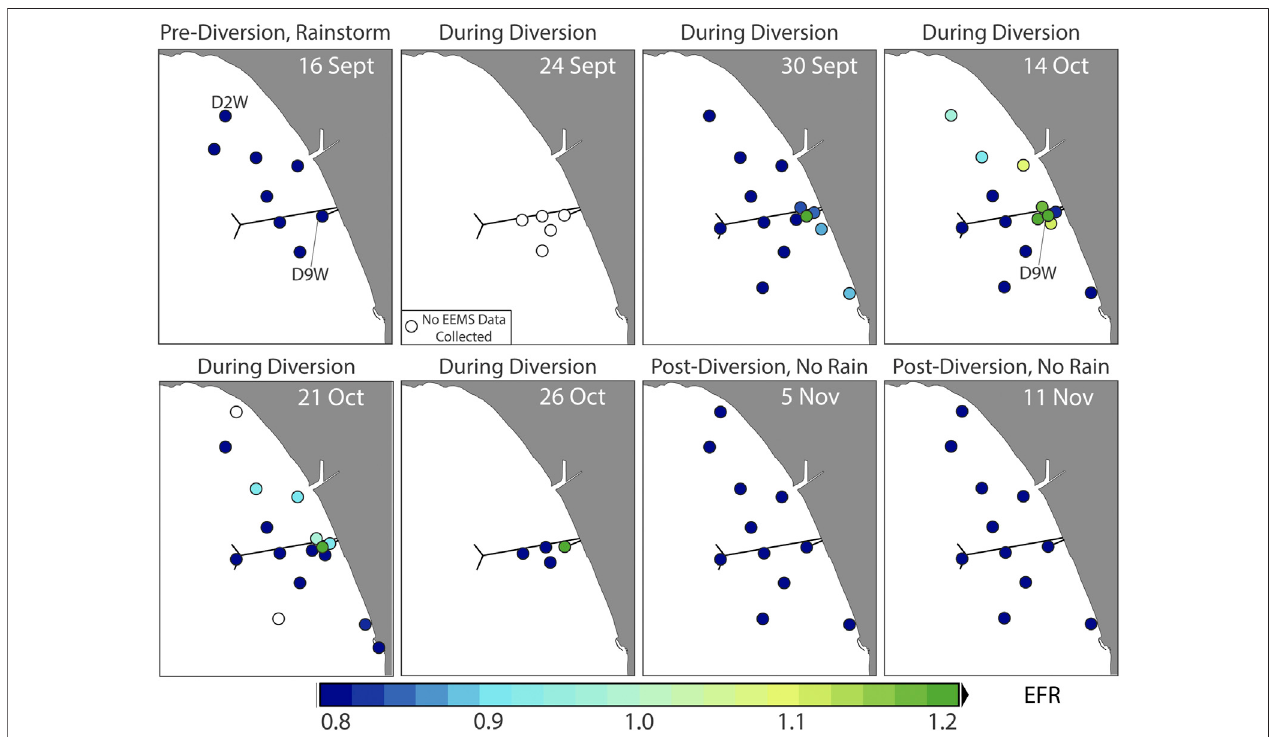
FIGURE7| Distributionof in-situEFR inSantaMonicaBayduringthesamplingwindow.NoEEManalysiswasconductedforSeptember24. EFR values > 1.0were only detected near the outfall during the diversion. Data from September 16 (after major rain event) show that the EFR is largely insensitive to runoff.